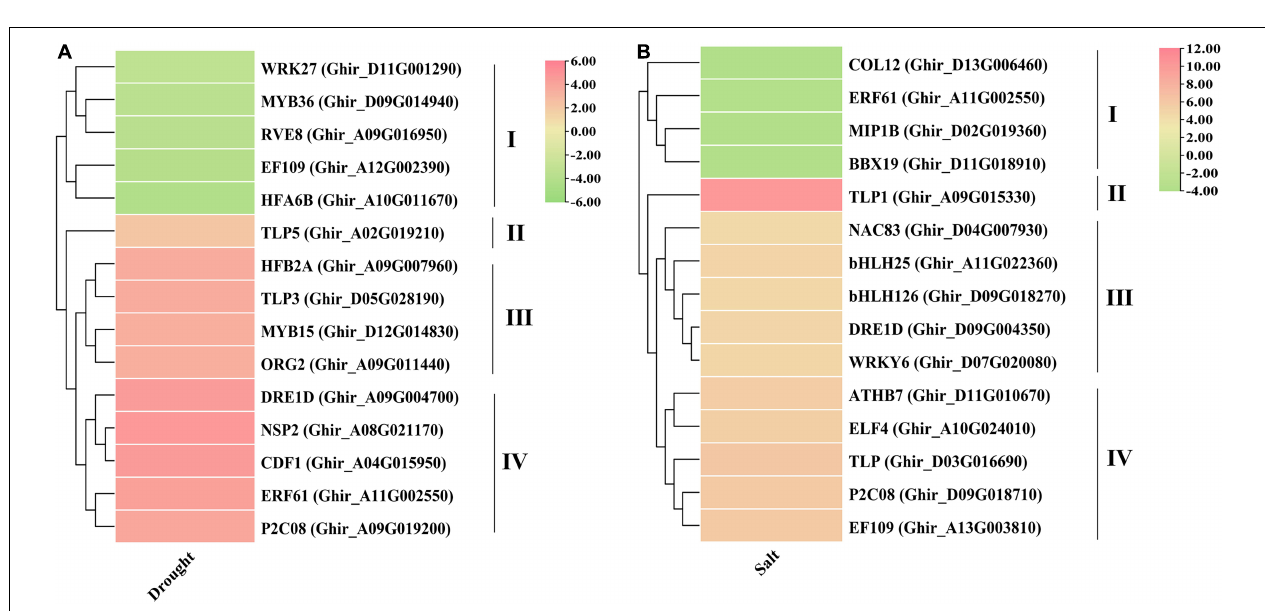
FIGURE 8 | Expression profiles of putative hub genes under (A) drought and (B) salt stress conditions. These expressions have been shown with the pheatmap package in R using Log2FC values.